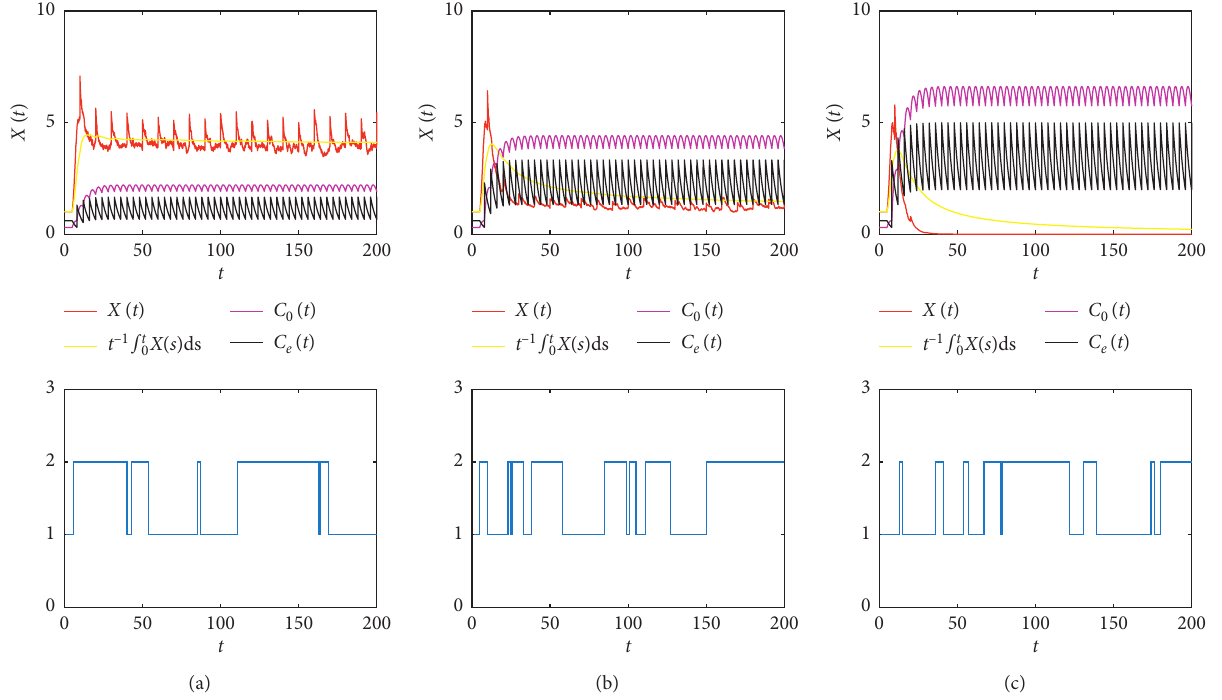
Figure 5: Effect of the exogenous total toxicant input: (a) u � 1; (b) u � 2; (c) u � 3.